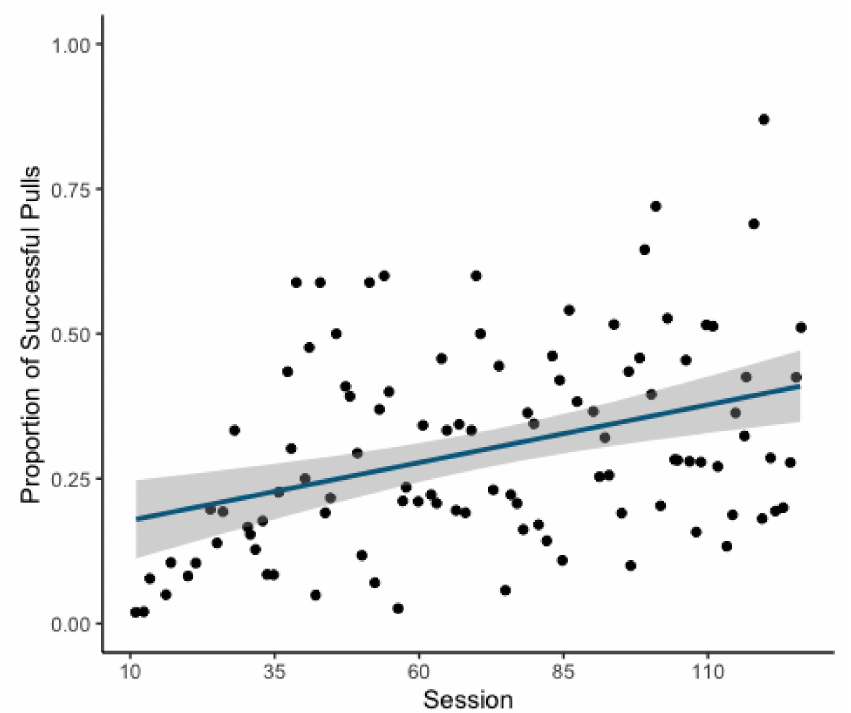
Figure 2. Scatterplot of proportion of successful pulls by session with line of best fit overlaid. Greyed area indicates standard